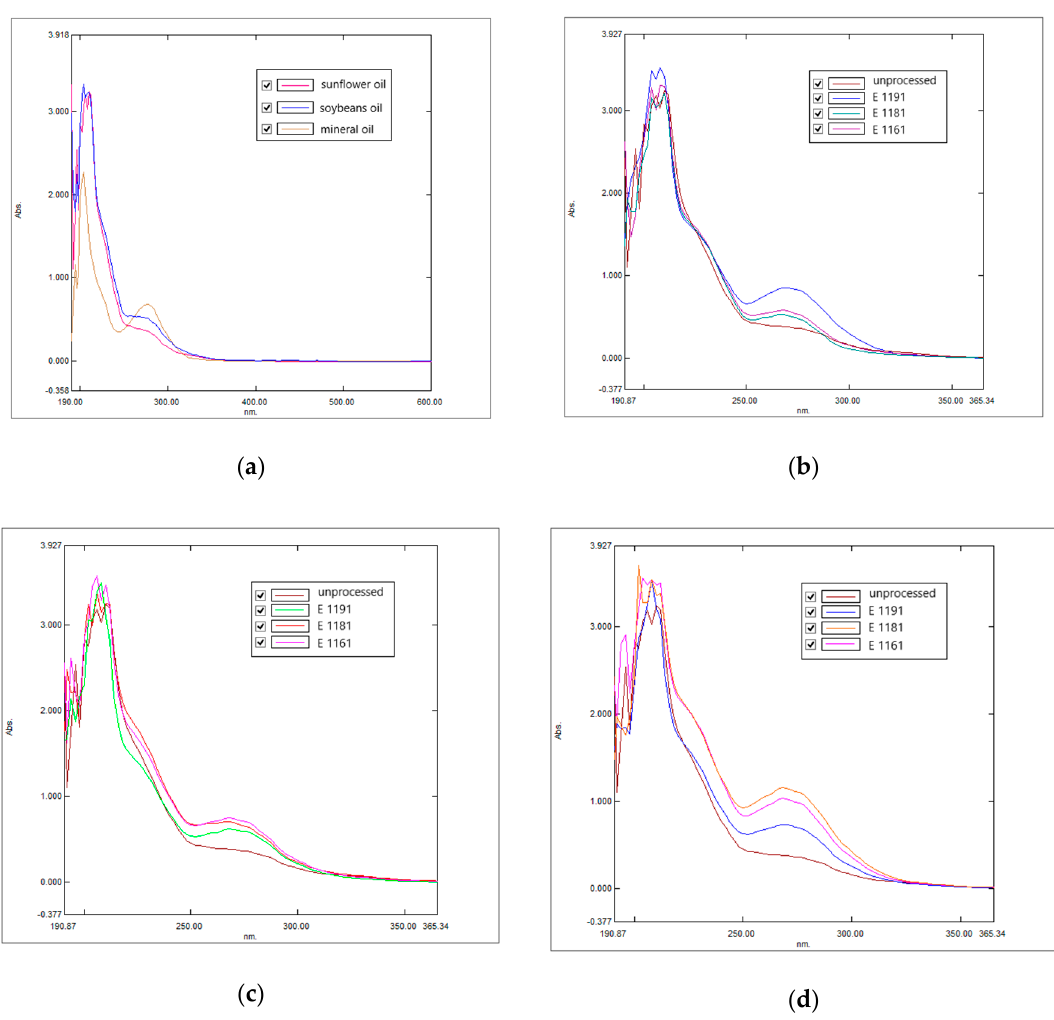
Figure 2. UV / Vis spectra of dielectric fluids: ( a ) Before machining; ( b ) Sunflower oil, before and after machining the 17–4 PH stainless steel; ( c ) Sunflower oil, before and after machining the AZ31B magnesium alloy; ( d ) Sunflower oil, before and after machining the AA 7075-T7351 aluminum alloy.